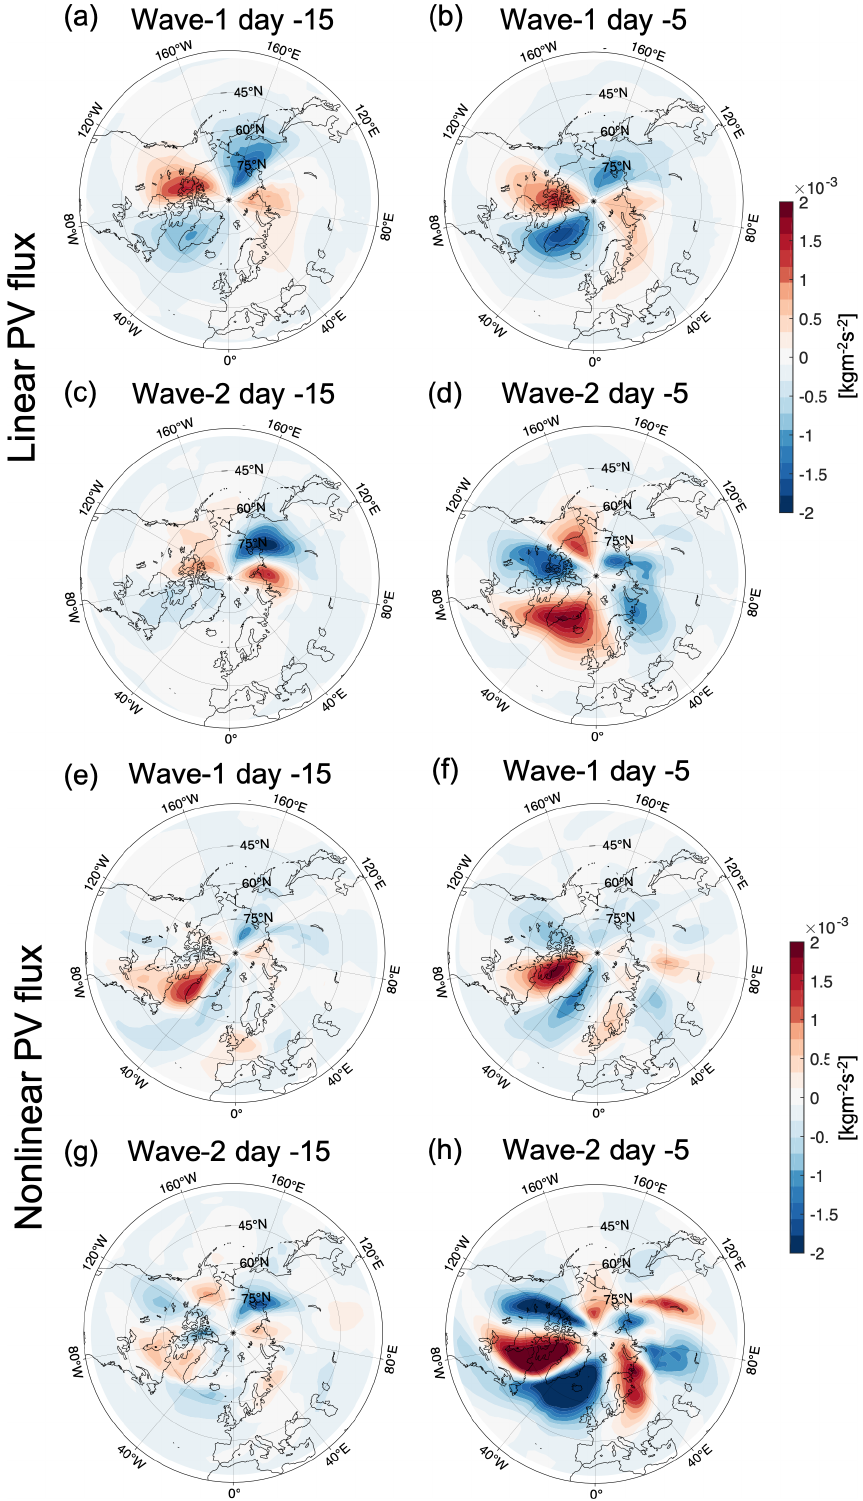
Figure 7. The spatial pattern of the linear PV flux for (a, b) the composite of wave-1 SSWs and (c, d) the composite of wave-2 SSWs. The spatial pattern of the nonlinear PV flux for (e, f) the composite of wave-1 SSWs and (g, h) the composite of wave-2 SSWs. Panels (a, c, e, g) show the spatial pattern at day − 15, and (b, d, f, h) show the spatial pattern at day − 5 prior to the